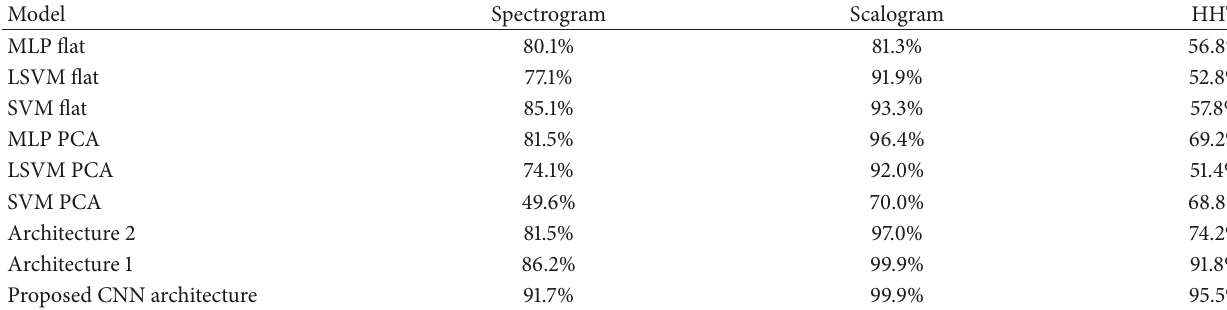
Table 7: Prediction accuracies for 96 × 96-pixel image inputs.